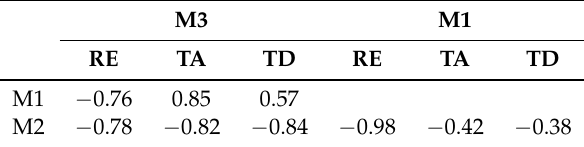
Table 5. Pearson correlation between continuity metrics for second transition. M1: task-resuming success rate, M2: average time to resume task in minutes, and M3: average seamless transition.